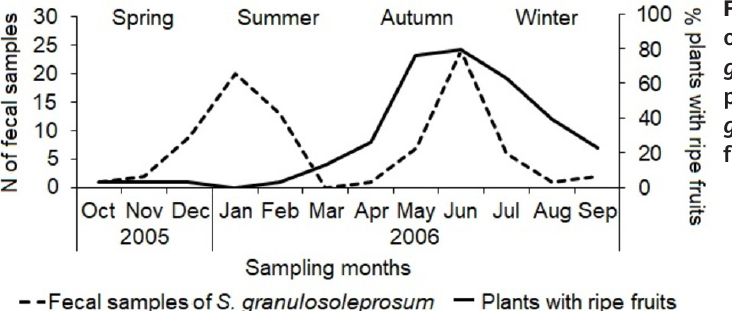
Figure 3. Seasonal number of fecal samples with S. percentage of plants of S.